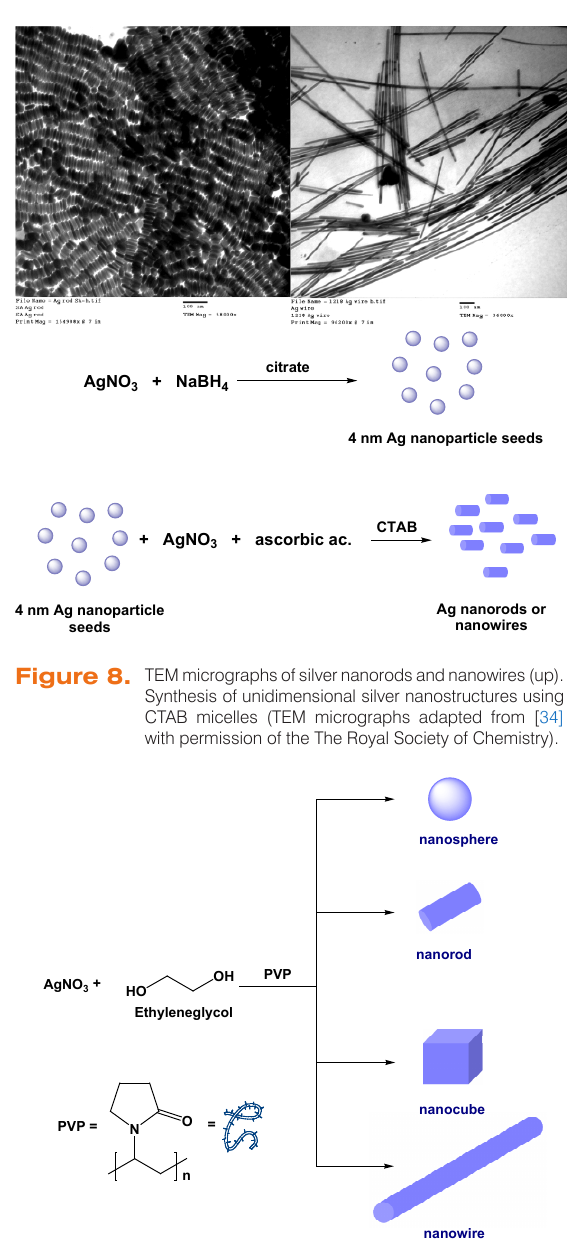
Figure 9. Different silver nanostructures synthesized through the reduction of silver nitrate in ethyleneglycol in the presence of PVP.